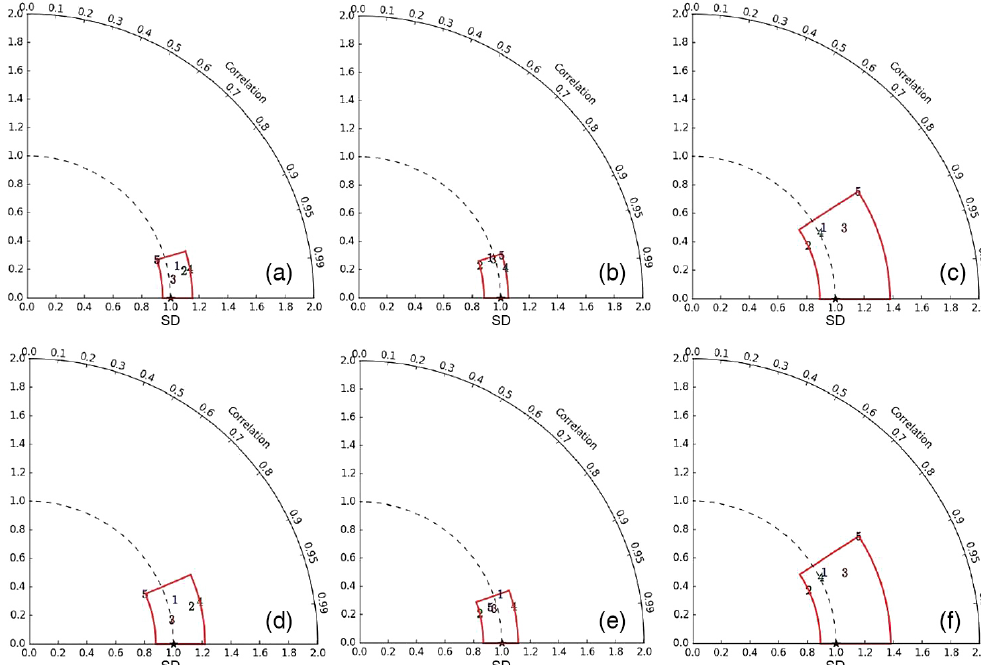
Figure 5. The spread amongst the five precipitation data sets in representing the spatial variability of the three climatological properties of the annual (upper panels) and summer (lower panels) precipitation over East Asia: (a, d) the mean, (b, e) the interannual variability, and (c, f) the trends of precipitation. They are presented in terms of their spatial pattern correlations (the azimuthal direction), the standardized deviation, and the standard deviation of individual data sets normalized by that of the reference data (the radial direction). The area within the red polyline represents the range of spread amongst these data